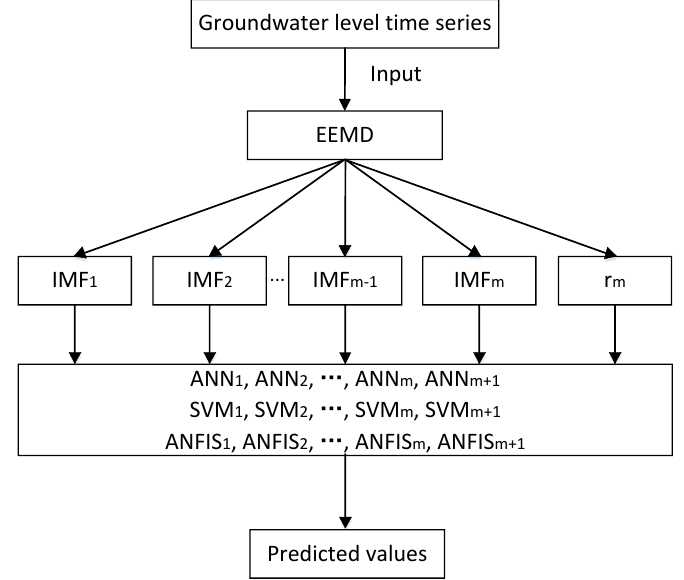
Figure 4. Schematic diagram of EEMD-ANN, EEMD-SVM and EEMD-ANFIS.